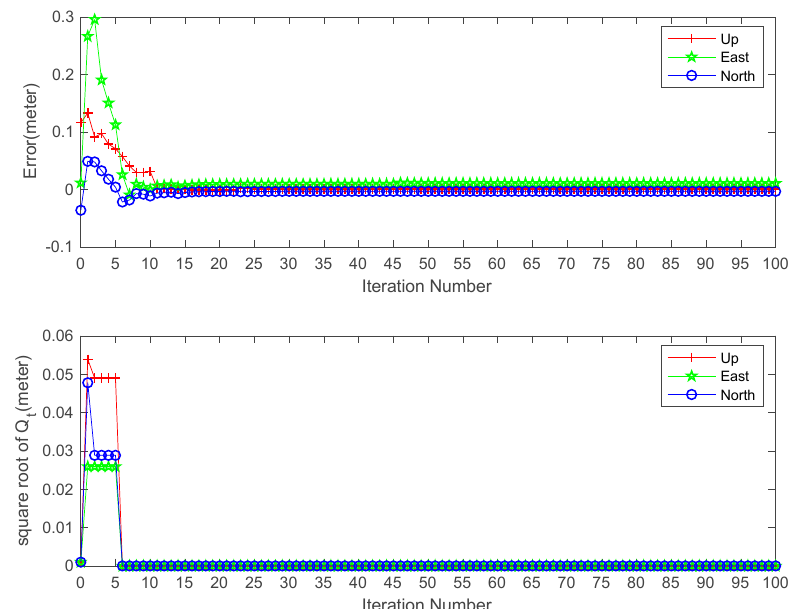
Figure 5. E ff ects of EM-PPP iteration number on the position errors (top) and variations of the square Figure 5. Effects of EM-PPP iteration number on the position errors (top) and variations of root of Q t at last epoch on station JFNG. the square root of 𝑄 (cid:3047) at last epoch on station JFNG.